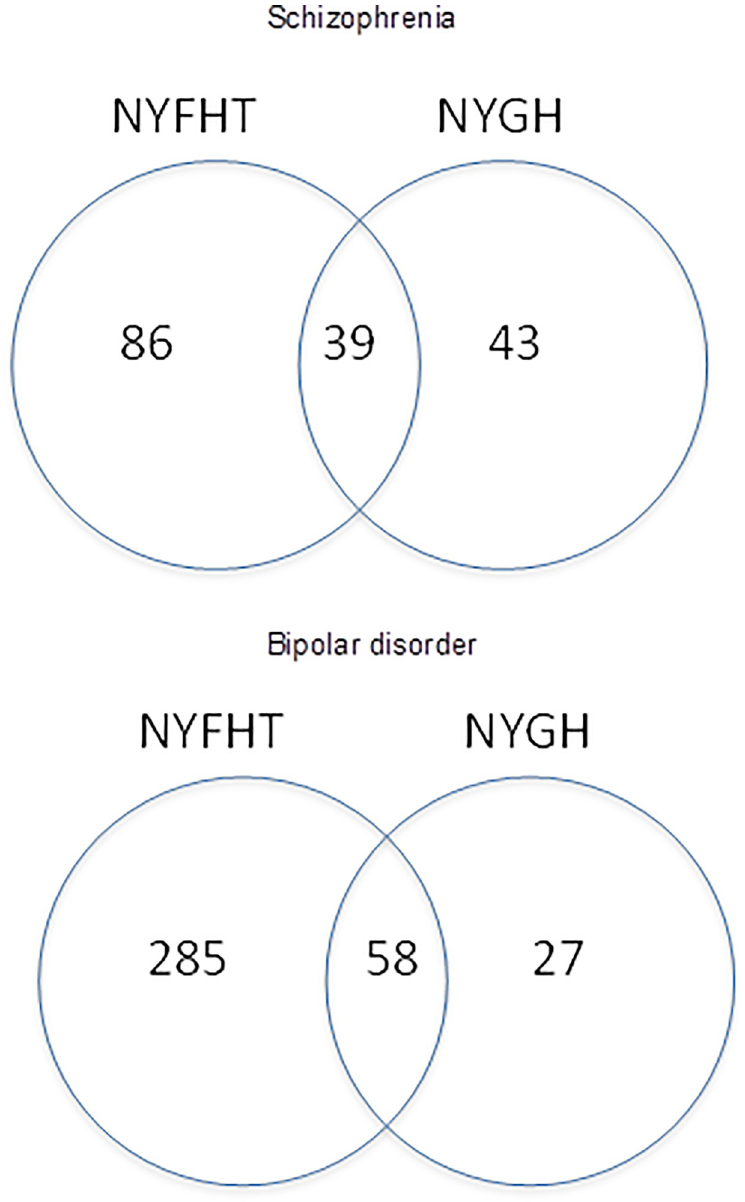
Fig 2. Location of diagnostic